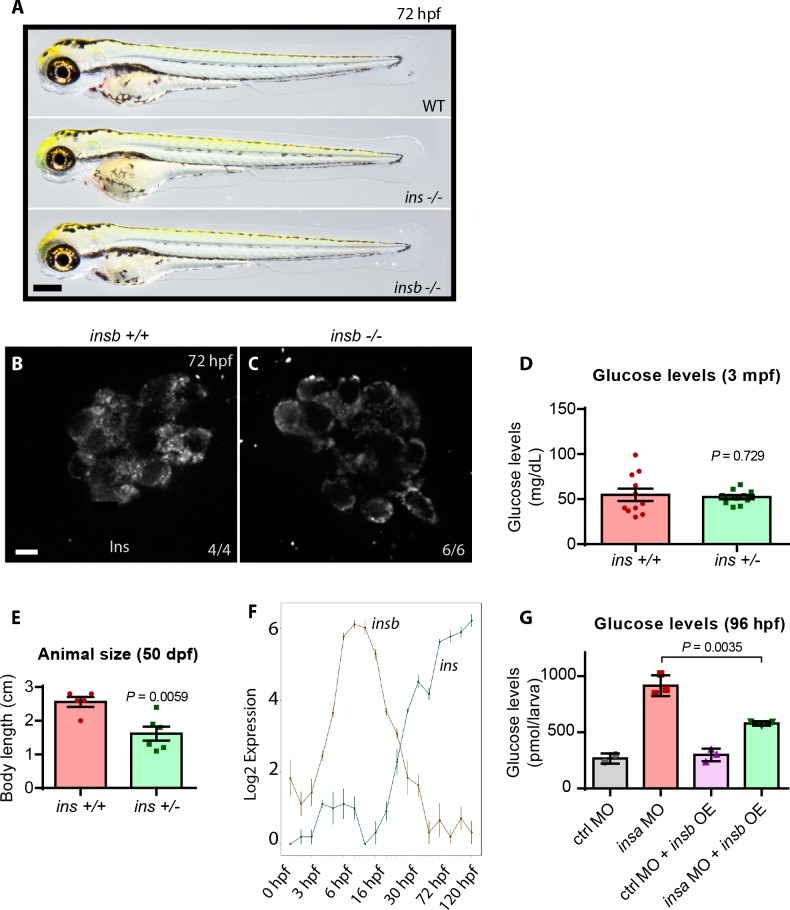
ins, and not insb, is the predominant paralog expressed in zebrafish pancreatic islets.(A) Brightfield images of 72 hpf wild-type, ins mutant and insb mutant larvae. (B–C) Confocal plane images of the pancreatic islet in 72 hpf wild-type and insb mutant larvae stained for Insulin (white). (D) Fasting blood glucose levels in three mpf wild-type and ins ± animals; mean ± SEM, n = 11 animals. (E) Body length measurements of 50 dpf wild-type and ins ± animals; mean ± SEM, n = 5–6 animals. (F) mRNA expression time course of ins and insb during zebrafish development from 0 to 120 hpf. (G) 4 ng of control (ctrl) or ins morpholino (MO) was injected in non-transgenic or Tg(ins:insb) (insb OE) embryos at the one cell stage and glucose levels measured at 96 hpf; mean ± SEM, n = 3 replicates. Scale bars: 250 μm (A), 5 μm (C, D). P values from t-tests.